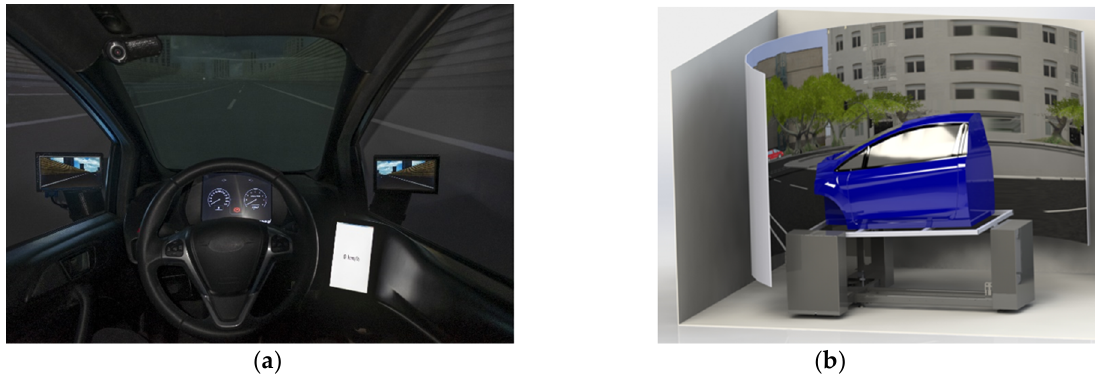
Figure 1. ( a , b ) Internal and external layout of the Figure 1. ( a,b ) Internal and external layout of the simulator.